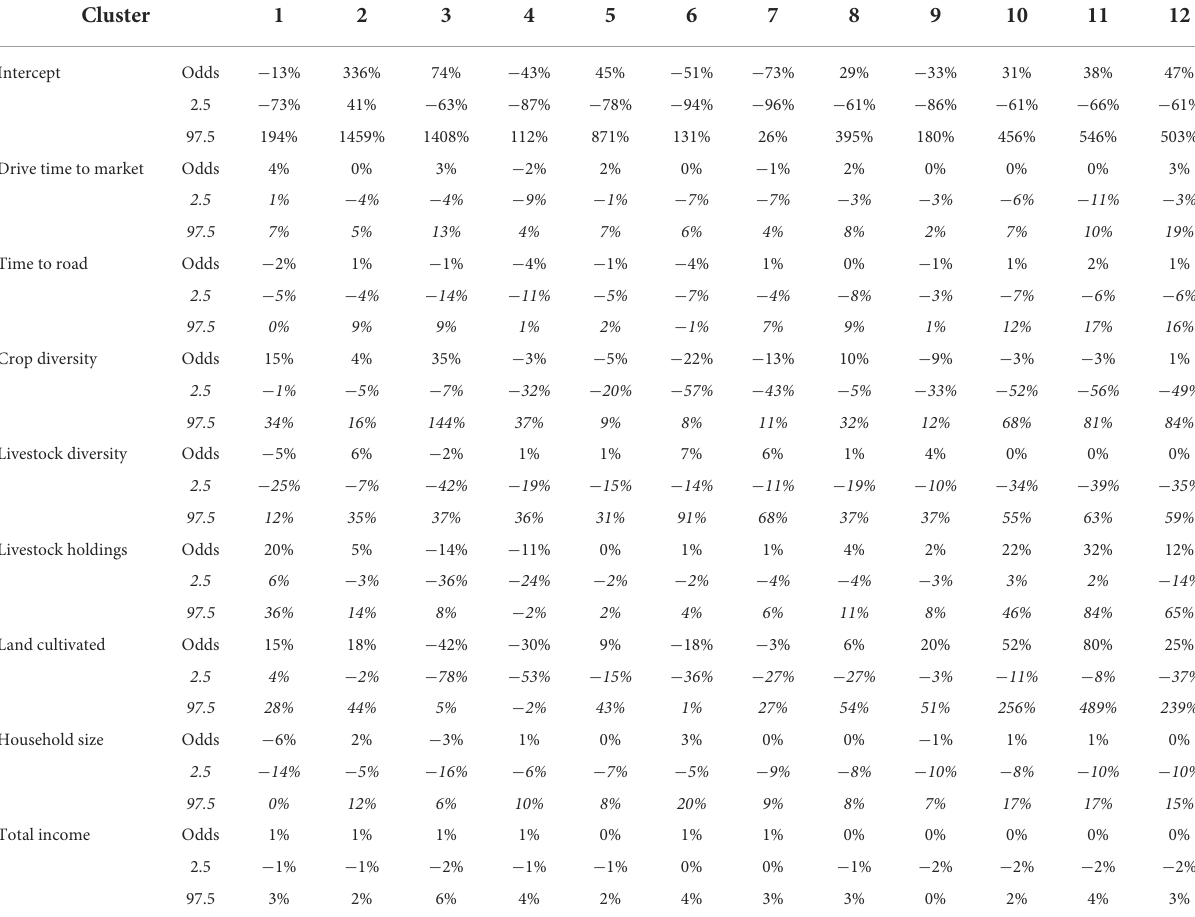
TABLE 2 Odds ratio of the effect of different variables to dietary diversity for each